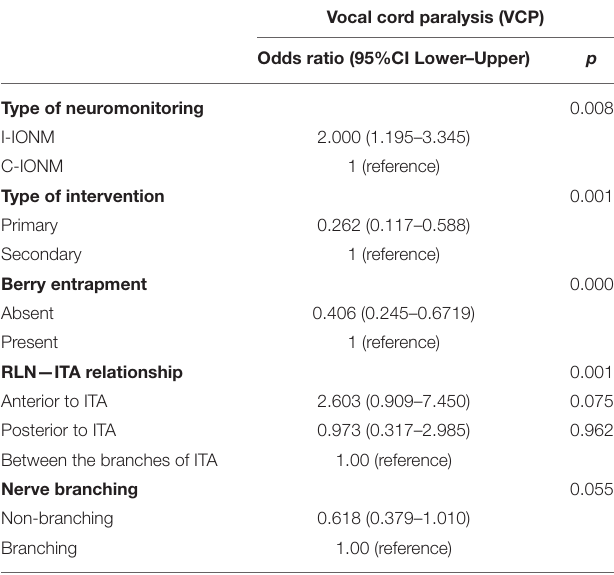
TABLE 4 | Multivariate analysis of risk factors for total VCP with binary logistic regression.